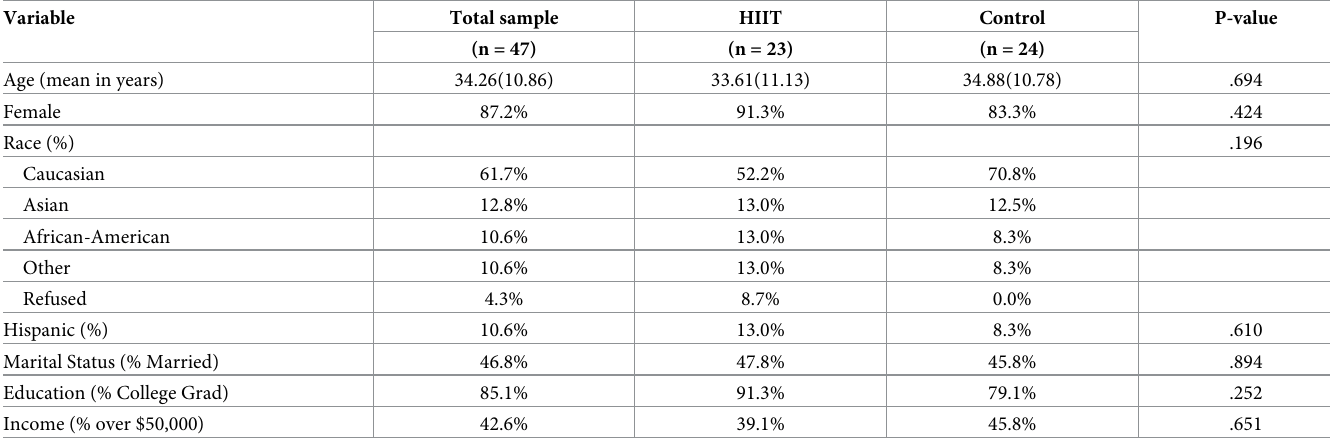
Table 2. Baseline characteristics by study